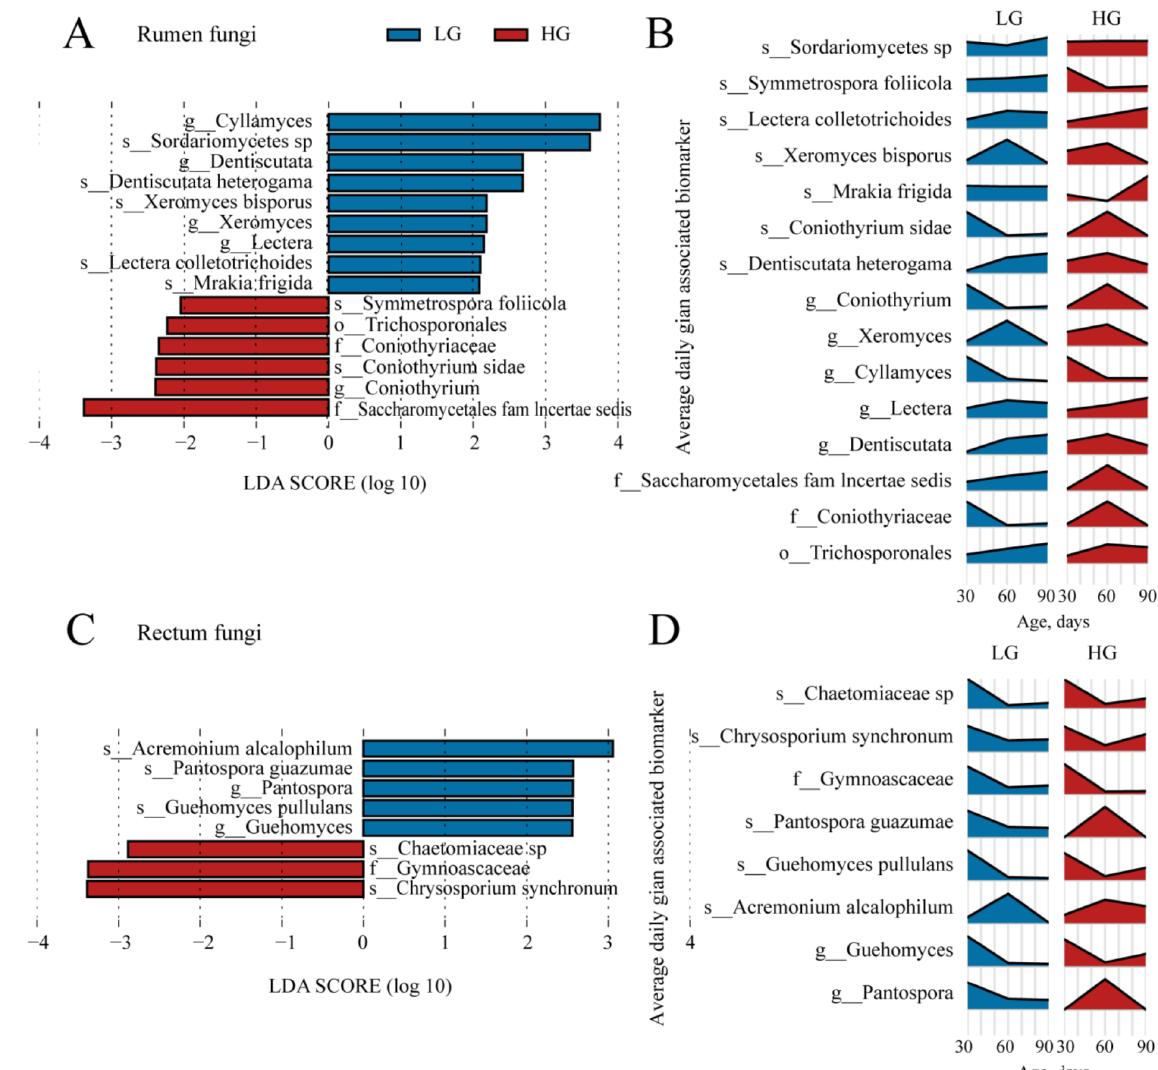
Figure 7. The identified fungal biomarkers in the rumen and rectum of lambs are between the five lambs with the lower average daily gain (LG) and the five lambs with the higher average daily gain (HG). ( A ) The identified fungal biomarkers in ruminal samples of lambs between the LG and HG groups using LEfSe analysis (LDA score > 2 and p < 0.05). ( B ) The changes over age show the relative abundances of the identified fungal biomarkers in the rumen. ( C ) The identified fungal biomarkers in rectal samples of lambs between the LG and HG groups using LefSe analysis (LDA score > 2 and p < 0.05). ( D ) The changes over age show the relative abundances of the identified fungal biomarkers in the